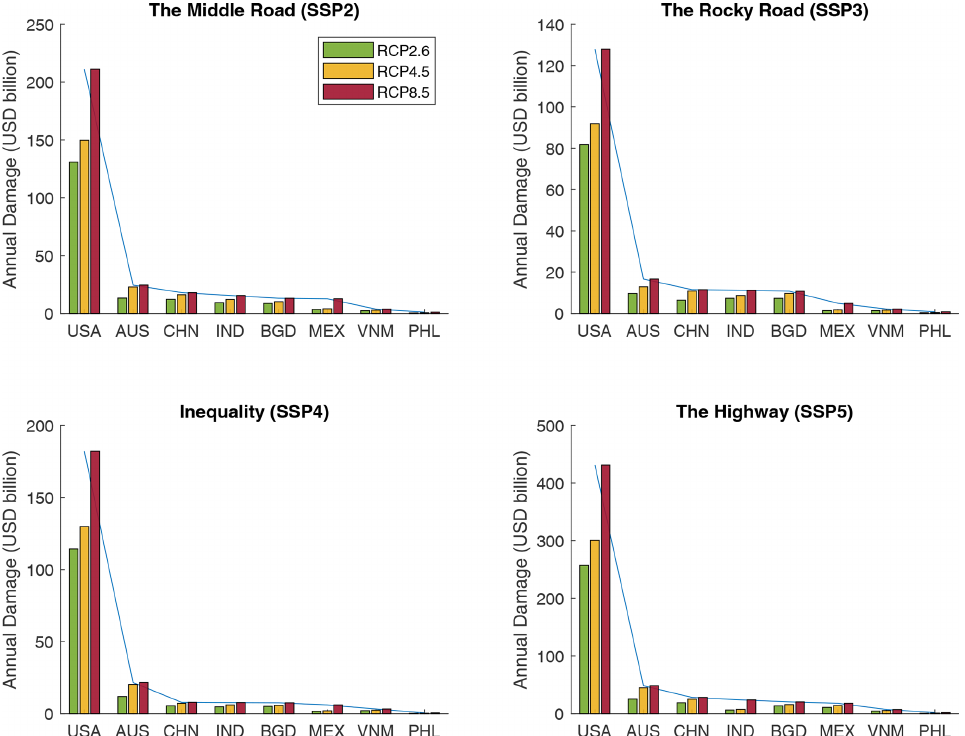
Figure 25. Annualized regional expected damage (in USD billion) in SSP and RCP between 2070 and 2100 based on synthetic tracks produced with seven climate models (with bias correction) over 300 representative years launched independently. The scale differs between